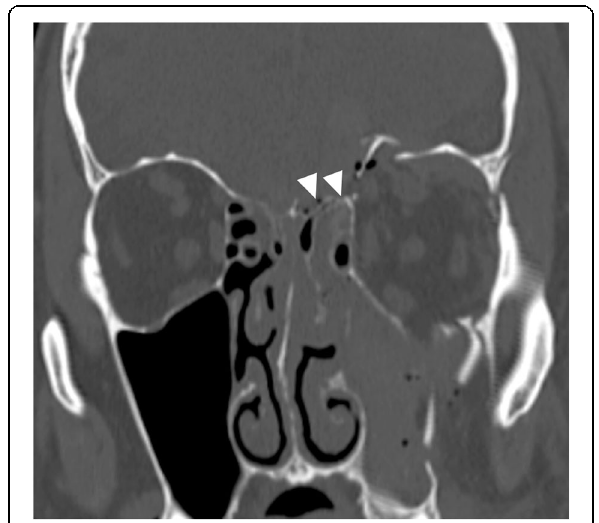
Fig. 29 Fracture of cribriform plate. CT coronal image shows multiple fractures of the skull base. Note in particular the fracture of the cribriform plate (arrowheads)